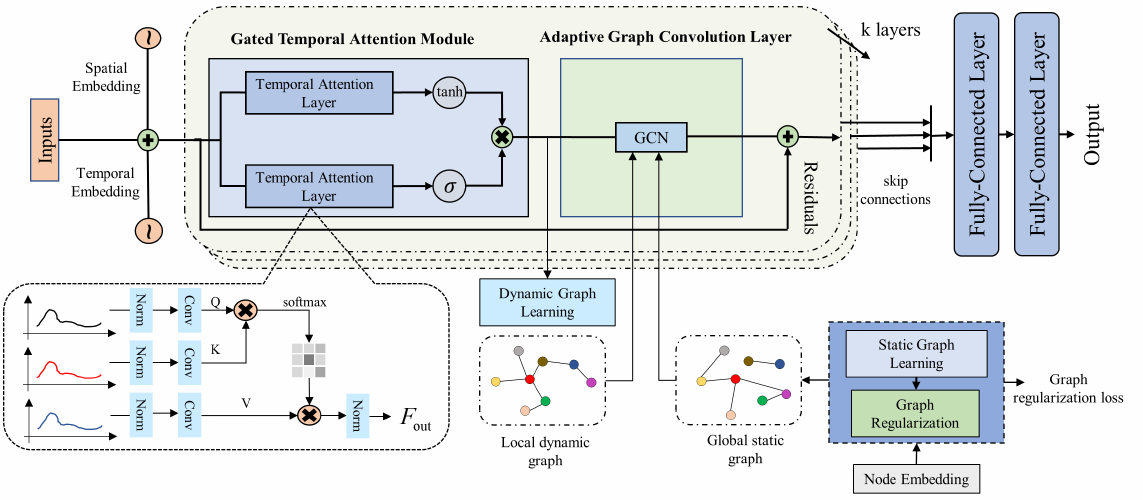
Figure 2. The framework of STAGCN. The model consists of a spatial static–dynamic graph learning layer, gated temporal attention module (Gated TAM), and adaptive graph convolution layer (GCN). The input and learned spatiotemporal embedding are first passed through Gated TAM, followed by the graph learning layer to obtain static and dynamic graphs. Then, feature representation and graphs are passed to GCN for spatial